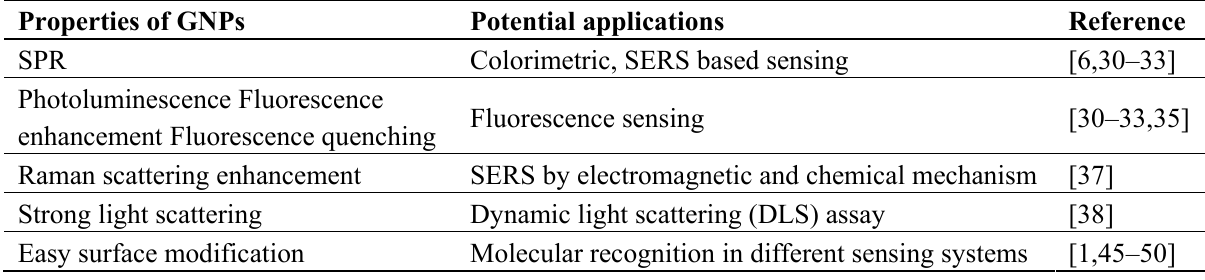
Table 2. List of properties of GNPs and their potential